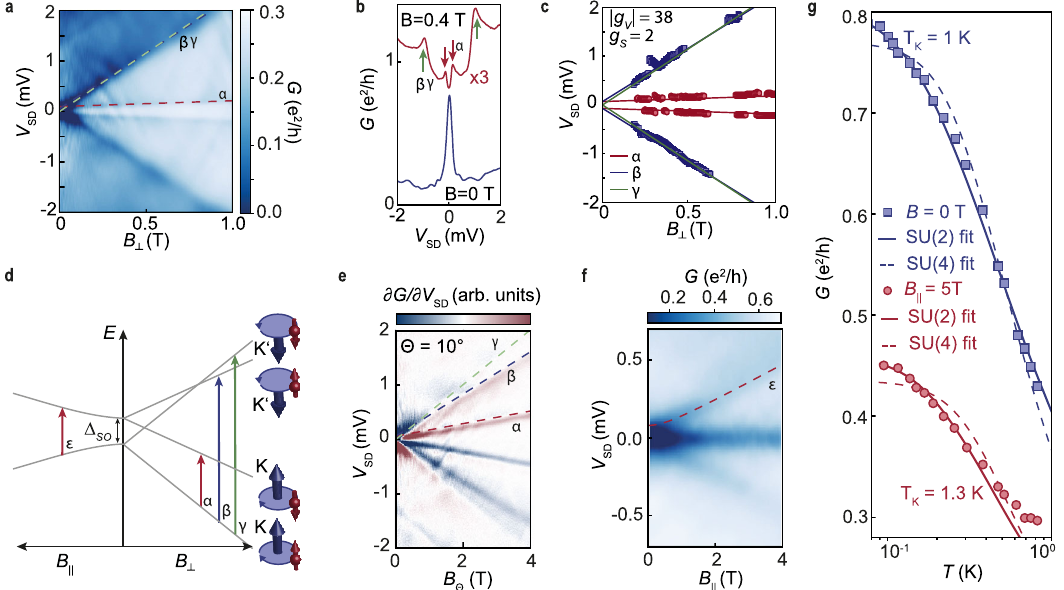
Fig. 2 Interplay between the spin – orbit coupling and the Kondo effect for N = 1. a Experimentally observed splitting of the Kondo resonance into four resonances in a perpendicular magnetic fi eld. The measurements are fully described by the energy levels in d with a valley g -factor of 38, an electronic g-factor of 2 and a spin – orbit splitting of 80 μ eV, which agrees with the earlier theoretical estimates 26 . b Line cuts in a at B = 0 and 0.4 T. c Evaluation of the conductance maxima in a using a peak fi nding algorithm. d Energy levels in bilayer graphene quantum dots in parallel and perpendicular magnetic fi elds, with a zero magnetic fi eld splitting due to the spin – orbit coupling Δ SO . The alignment of the magnetic moments is shown with four small icons, where the red arrow represents the spin magnetic moment and the blue arrow the valley magnetic moment. A parallel alignment between the spin and valley magnetic moments is preferred. e Derivative of measurements of the Kondo resonance with an angle of 10 ∘ between the magnetic fi eld and the sample plane showing all energy transitions. f Splitting of the Kondo resonance in a parallel magnetic fi eld. The Kondo resonance splits into three resonances: two from the spin splitting and one from the valley Kondo resonance that is not in fl uenced by a parallel magnetic fi eld. g Temperature dependence of the maximum conductance of the Kondo resonance, showing a lifting of the SU(4) symmetry, due to the spin – orbit coupling. For zero magnetic fi eld the SU(2) Kondo model with a Kondo temperature of 1 K describes the experimental data